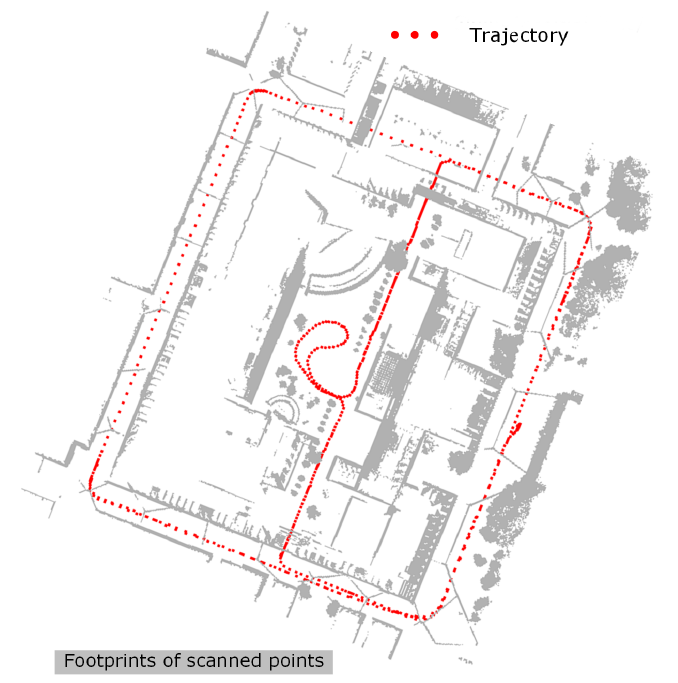
Figure 9. Vehicle trajectory. The red points correspond to equal time steps during the data acquisition, and the gray background indicates the footprint of scanned